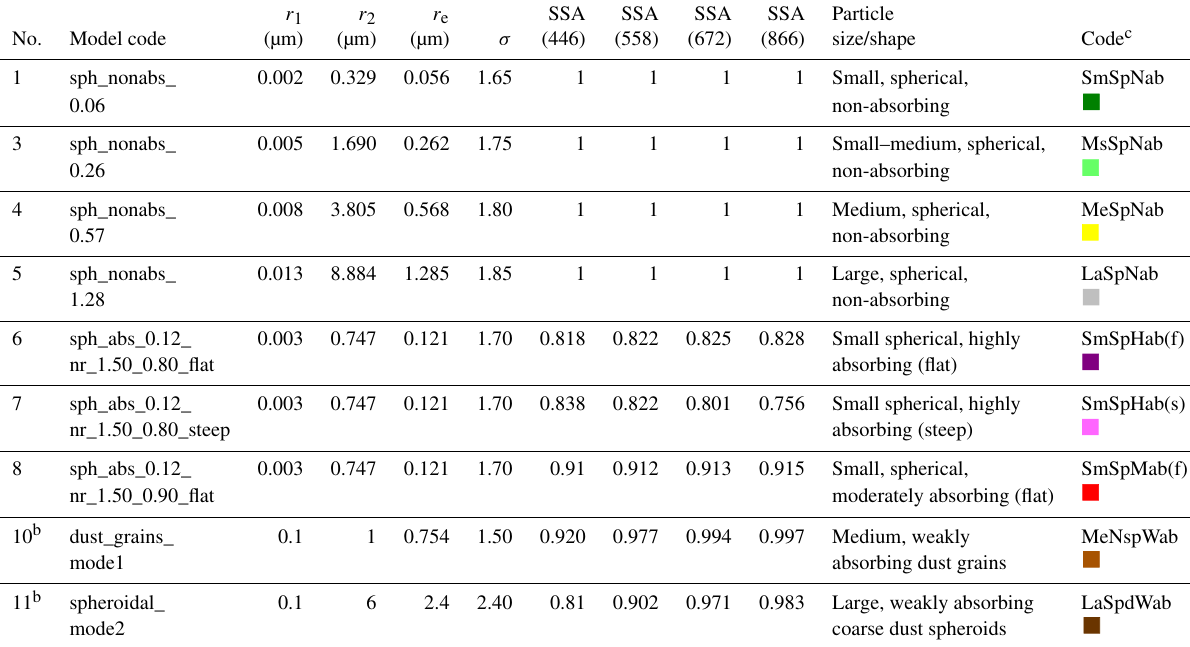
Table 2. MISR components from 774-mixture model identified in Karymsky plumes.